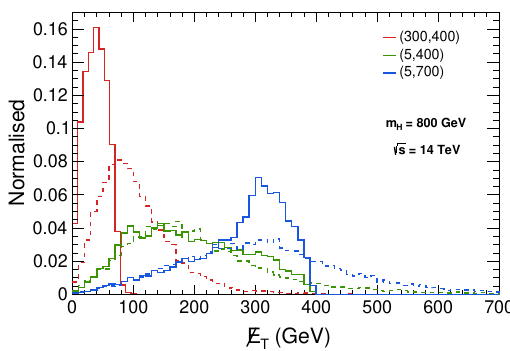
Figure 25. Normalised distribution of /E left plot of figure